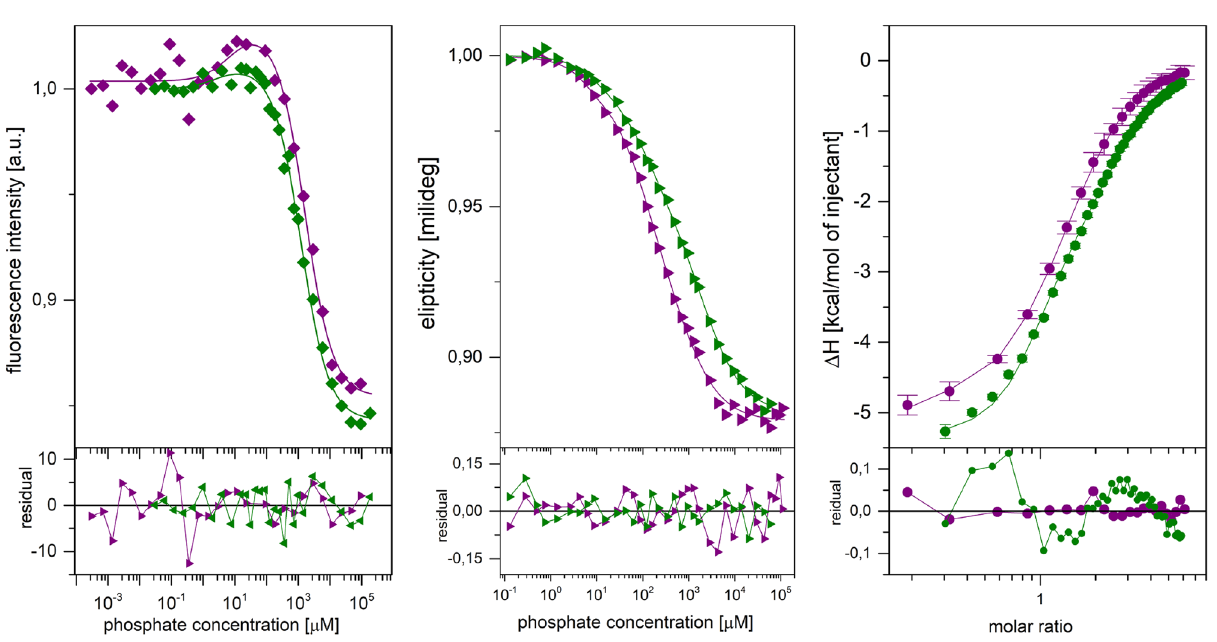
Figure 5. Thermophoretic titration curves of the enzyme with phosphate (left panel), CD titration curves of the enzyme with phosphate (middle panel), calorimetric titration curves of enzyme-phosphate complex with formycin A (right panel). On each panel data for the WT enzyme (violet) and the Y160W mutant (green) are presented: data (points), global best fit model (lines) and residual plots below. For the sake of clarity the number of data has been limited to one curve from each titration series. Complete data are shown in the Supplementary Information. Titrations were performed at 25 °C, in 50 mM Tris/HCl buffer pH 7.6. For each method and each protein variant the curve with the largest change of the measured physical property was